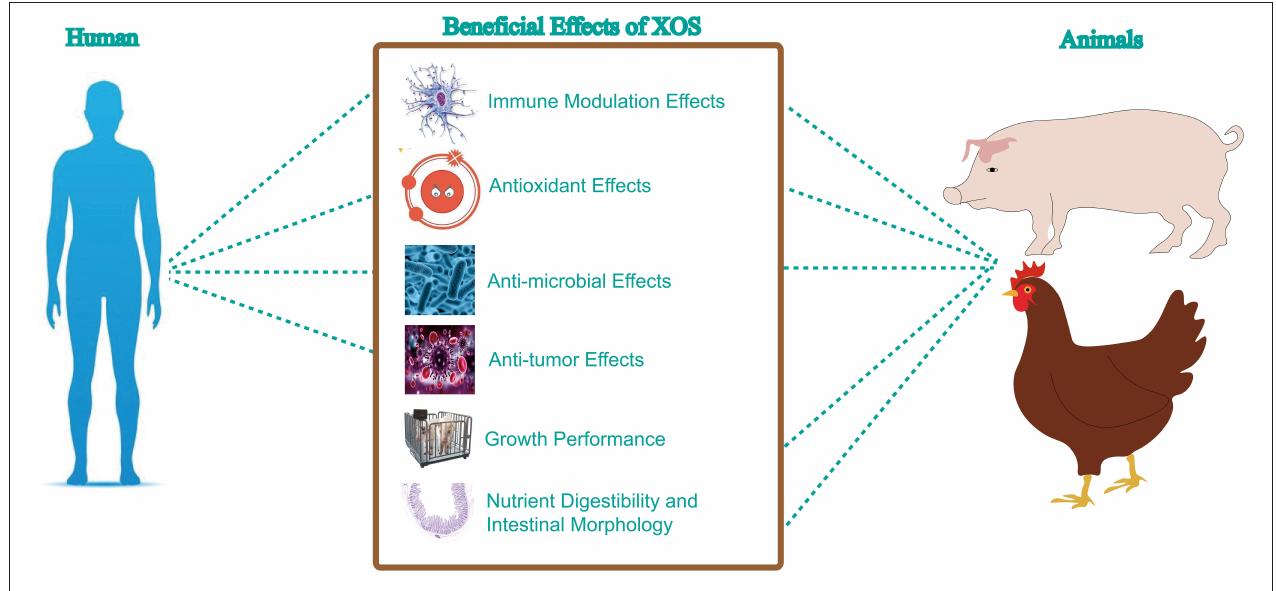
FIGURE 5 | Health beneficial effects of